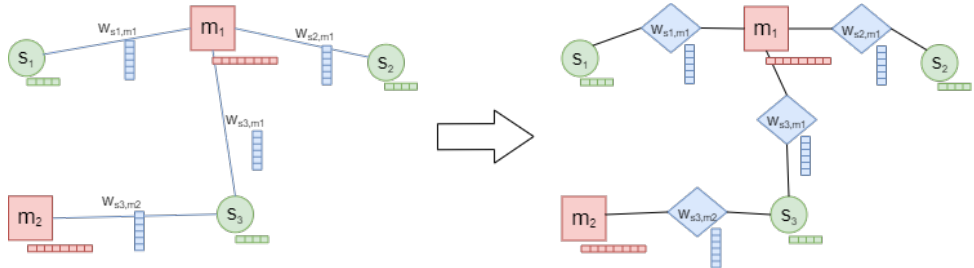
Figure 3. From the standard topology (on the left) to the proposed one (on the right). We replace each interaction edge with three entities: an interaction node (blue diamond) and two edges that connect it to siRNA (green circle) and mRNA (red square),